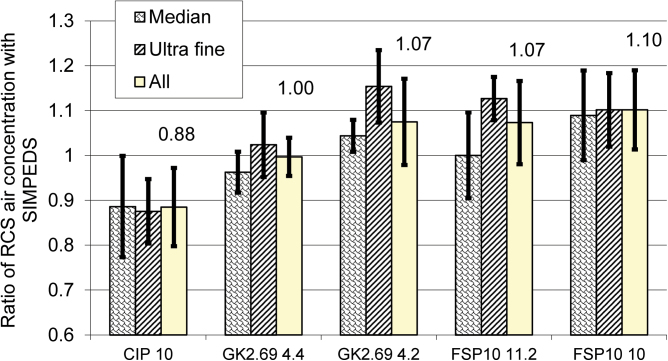
Ratio of RCS with SIMPEDS.